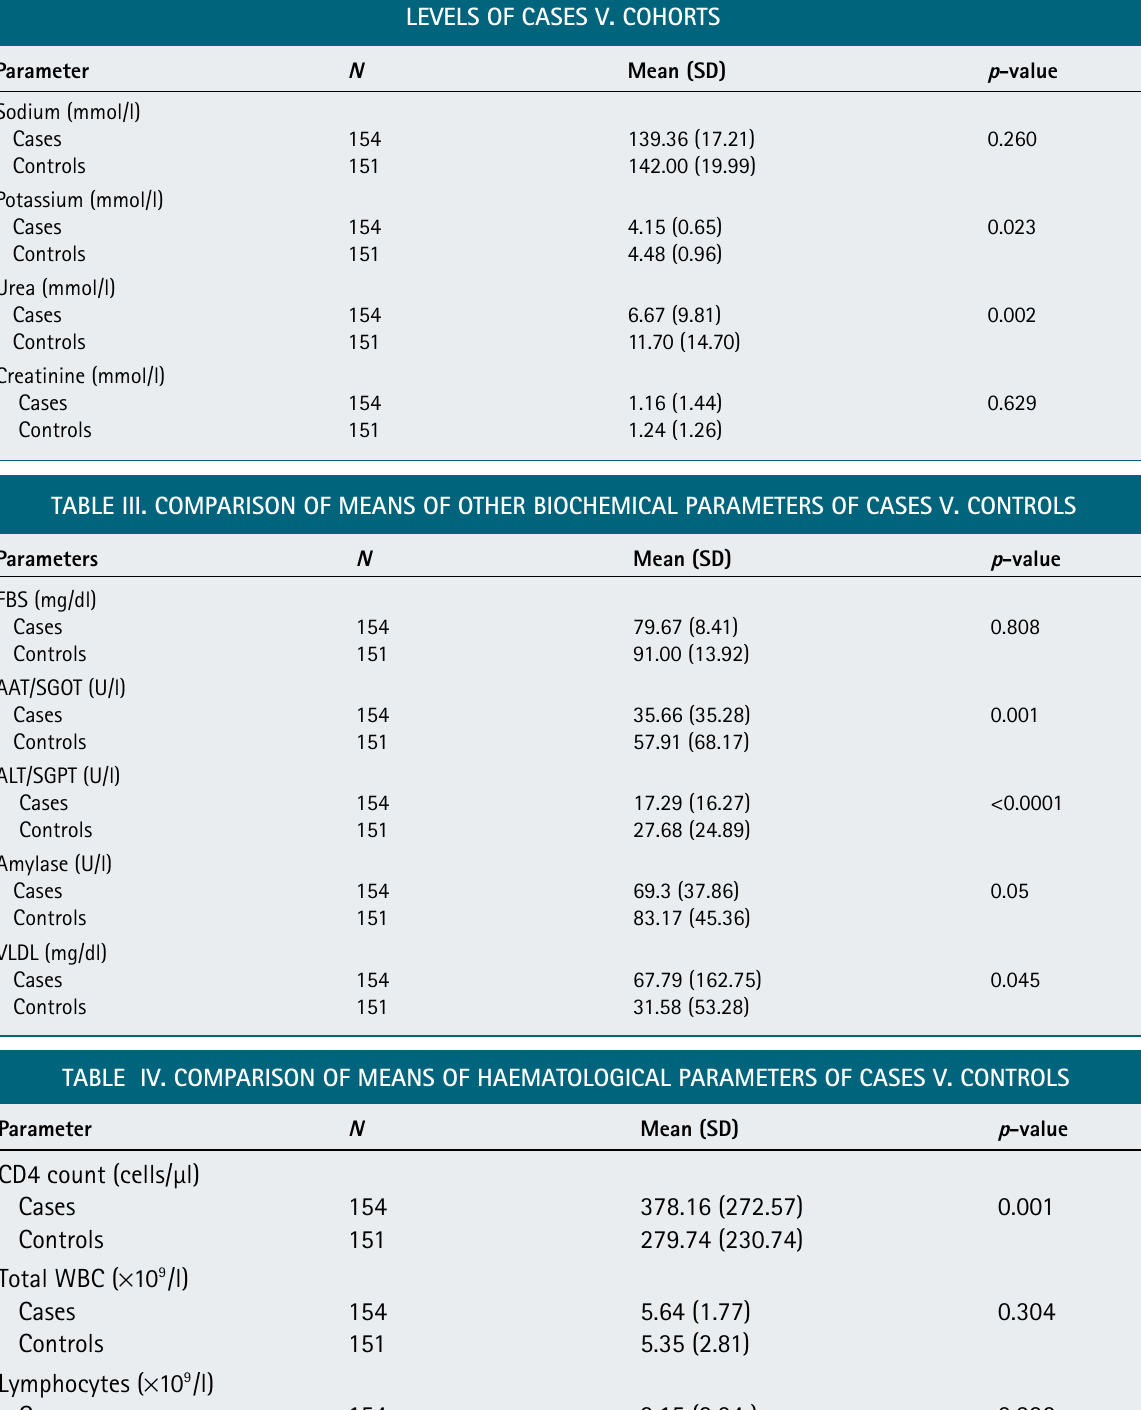
taBle ii. coMPariSon oF MeanS oF SerUM electrolYte, Urea anD creatinine